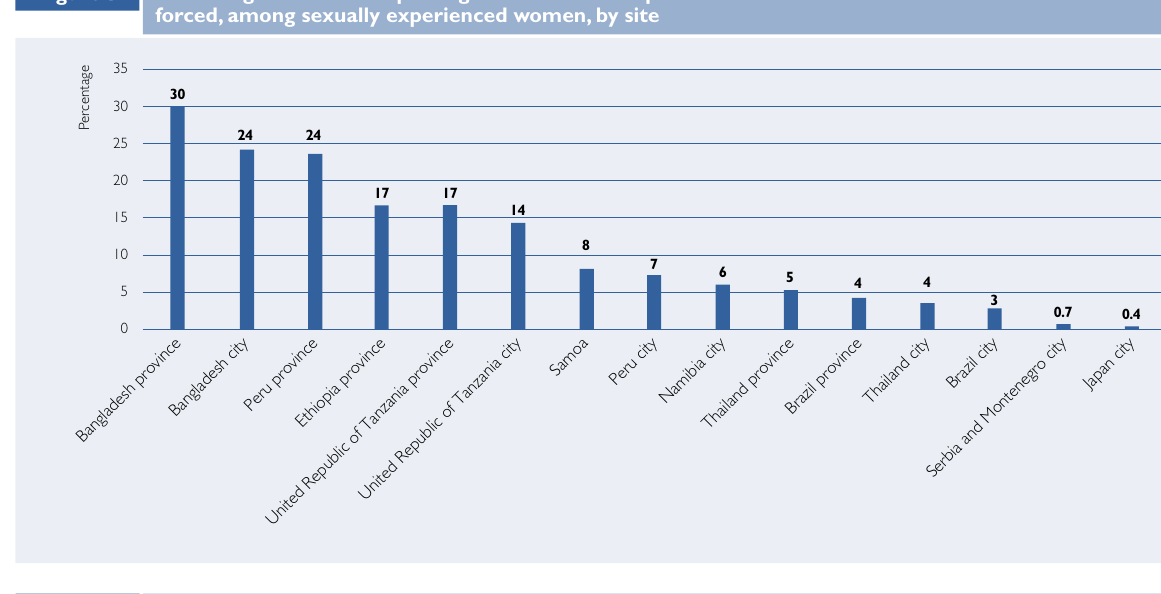
Percentage of women reporting that their first experience of sexual intercourse was forced, among sexually experienced women, by site